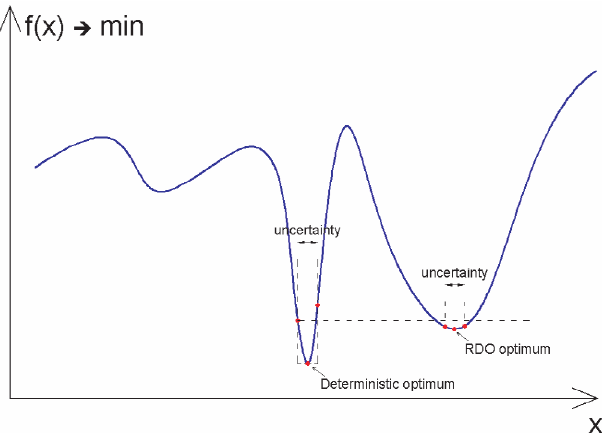
Fig. 2. The concept of robust design